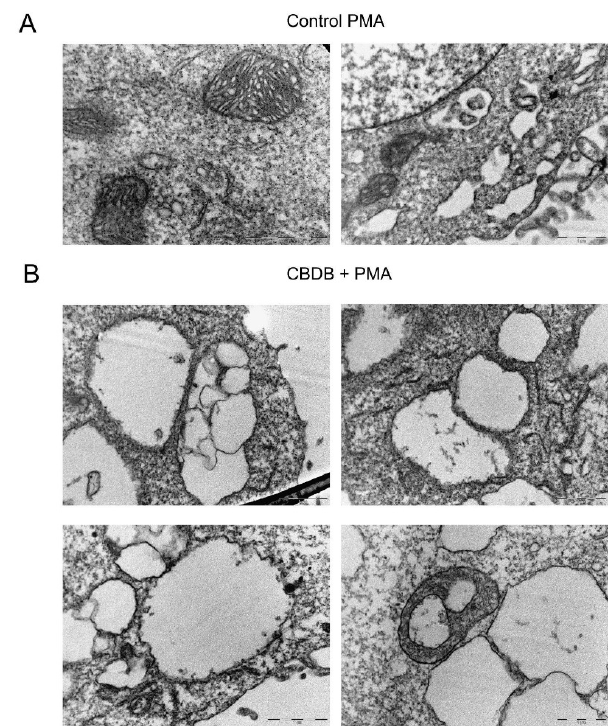
Figure 9. Representative TEM images of cell morphology. ( A ) MCF-7 cells were treated with vehicle (DMSO) and PMA (100 nM), showing normal cell organelles. Scale bar 2 µ m. ( B ) MCF-7 cells were incubated with CBDB + PMA (100 nM), highlighting the presence of cytoplasmic vacuolations related to disassembled ER and mitochondria. Scale bar 1 µ